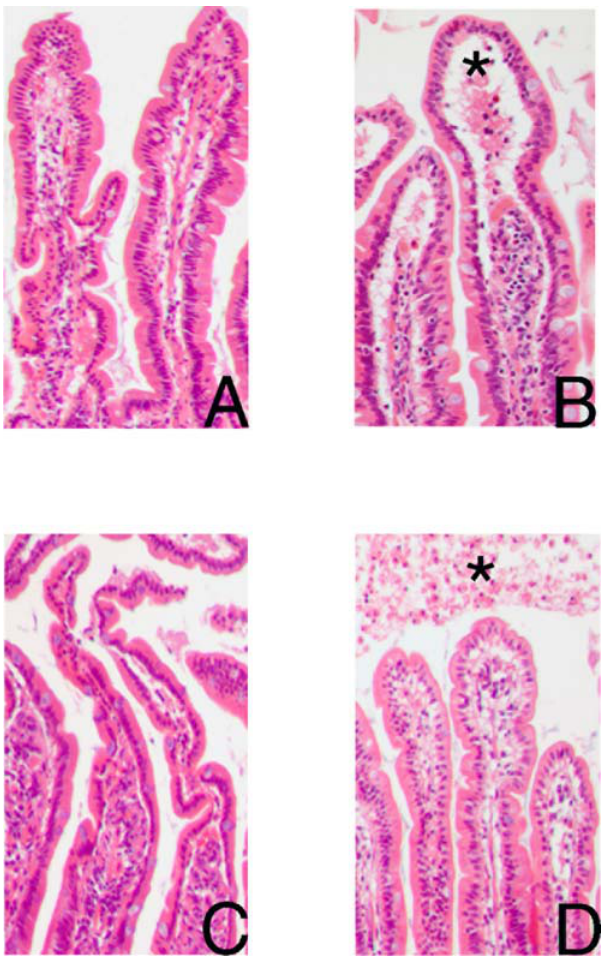
Figure 2. Immunolocalization of I-FABP in red (3-amino-9- ethylcarbazole, AEC) (100 6 ) in the control jejunum not subjected to ischemia-reperfusion (A) shows an abundant cytosolic presence of I-FABP in the epithelial cells of the upper half of the villus. Upon 30 minutes ischemia (B), cytosolic I-FABP staining is decreased in mature enterocytes with abundant staining in the subepithelial spaces. A decreased cytosolic staining is still observed after 25 minutes reperfusion (C). Within 60 minutes reperfusion, I-FABP cytosolic positive cells are part of the resealed epithelial barrier (D), while shedded I-FABP containing enterocytes are found in the debris in the lumen.